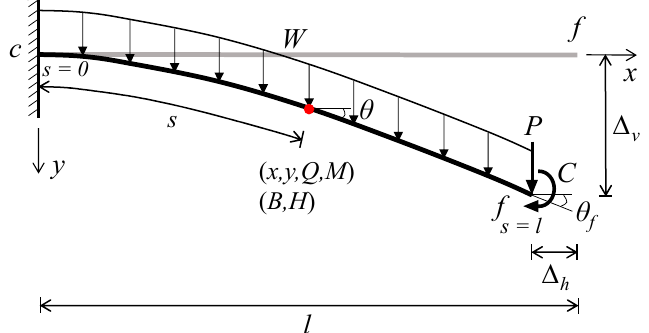
Figure 2. Elastica of cantilever beam under combined loading.